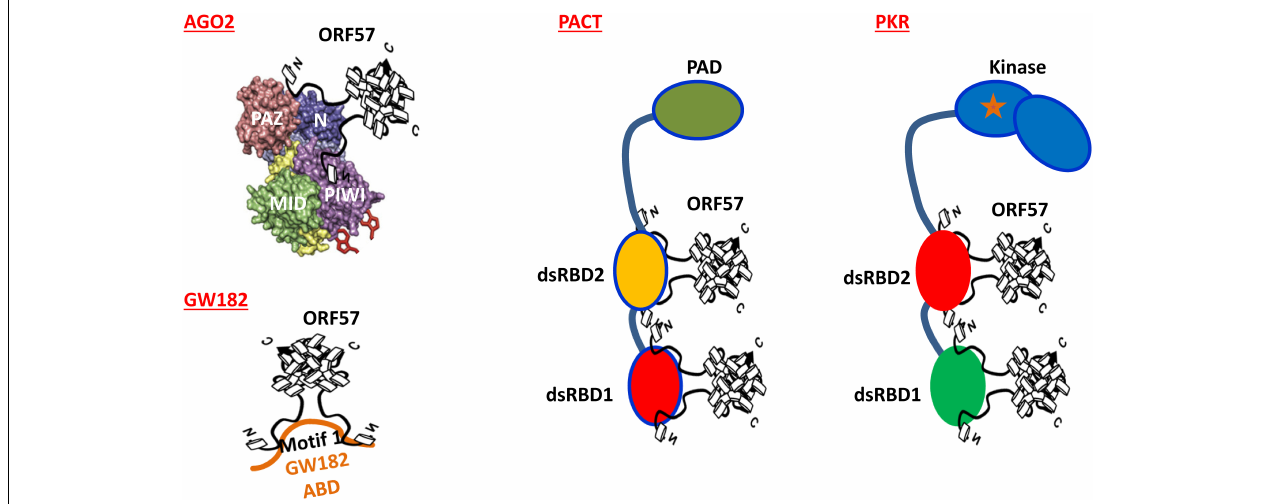
FIGURE 3 | Mechanisms of how KSHV ORF57 blocks the formation of both PB and SG in mammalian cell. Dimeric ORF57 interacts with the N domain of Ago2 and the motif 1 of GW182 Ago2-binding domain (ABD) to prevent Ago2-GW182 interaction, subsequently blocking PB formation in mammalian cells. Dimeric ORF57 also directly interacts with two dsRNA-binding domains (dsRBDs) of both PACT and PKR to block PKR dimerization and PKR kinase activation, thus preventing SG formation in the cells subjected to stress.